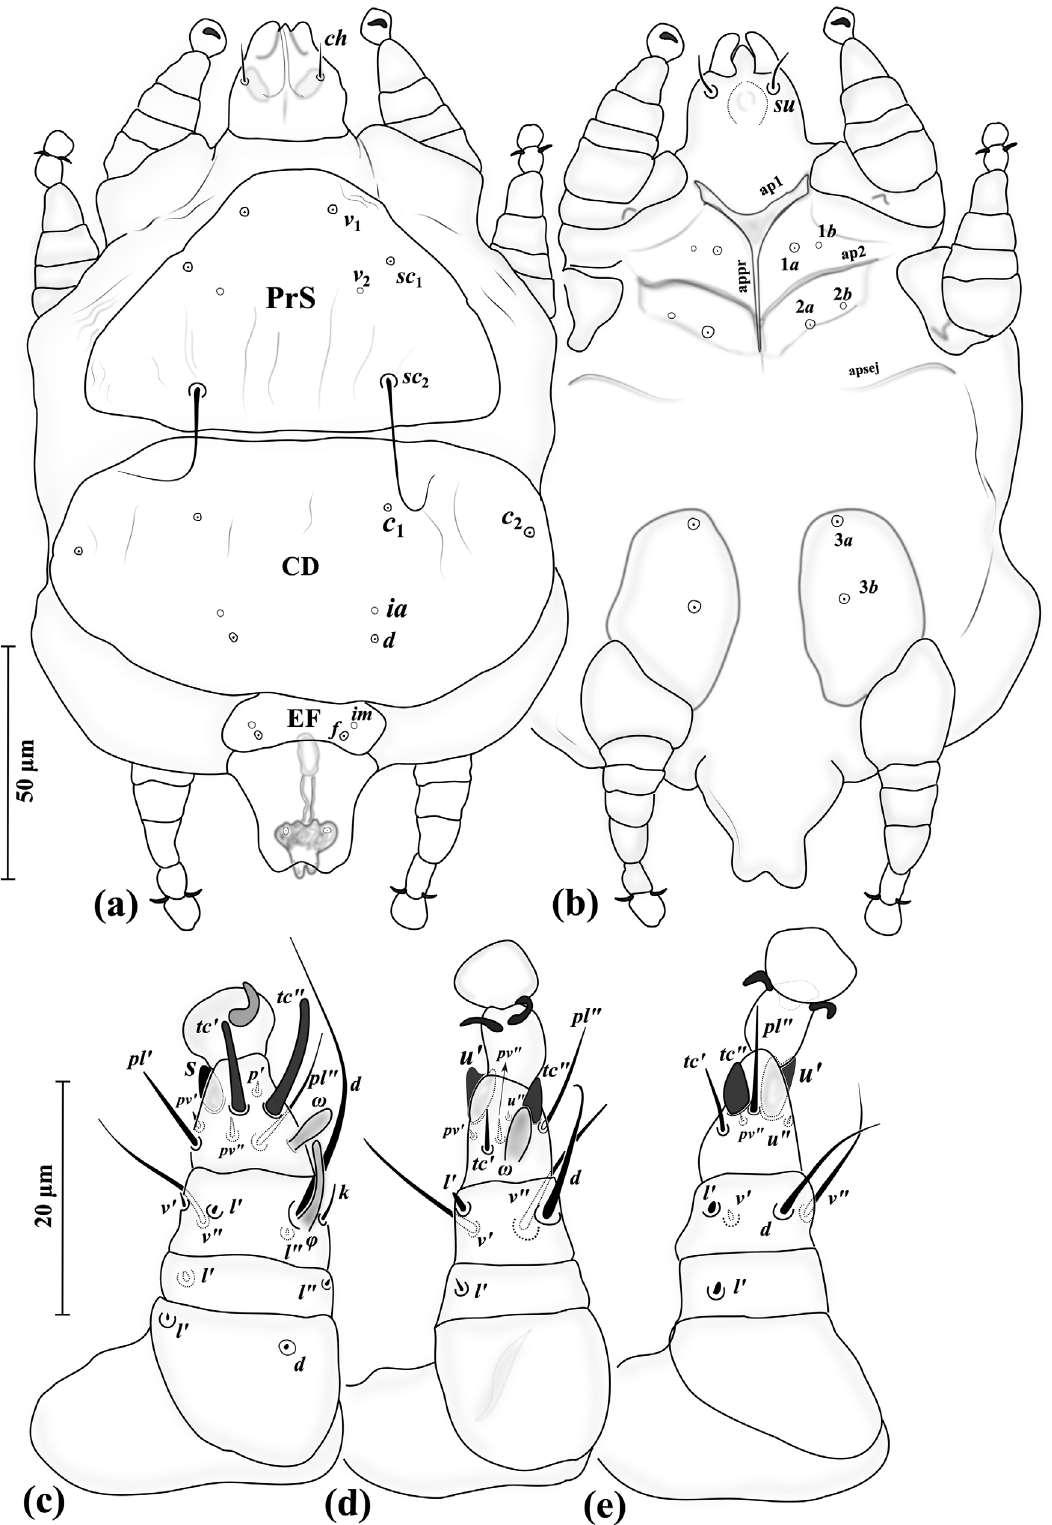
Figure 7. Eutarsopolipus pulcher n. sp. (male). (a) Body dorsum; (b) body venter; (c) right leg I; (d) right leg II; (e) right leg III. All legs in dorsal